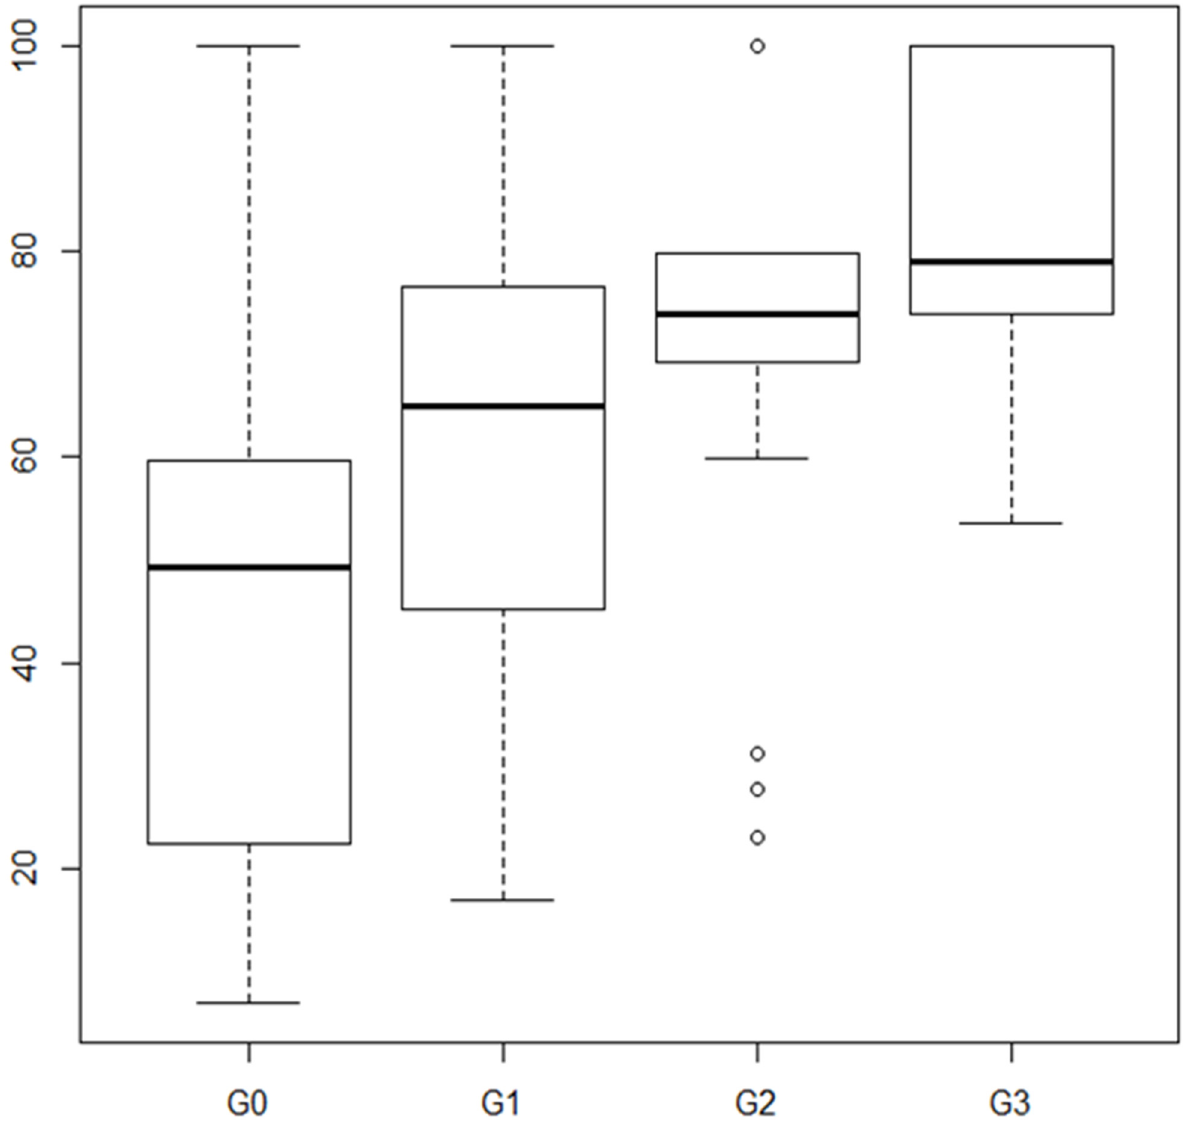
Figure 2. Relationship between quality of life (VAS) and the groups resulting from categorizing the score obtained by the estimated predictive model. Table 3. Relationship between VAS and the explanatory variables. In the dichotomous variables, 0 is NO and 1 is YES. The values 0, 1, 2, and 3 for age, menarche, menopause, and BMI correspond to the respective values for the first, second, third, and fourth quartiles. For the number of children, 0 corresponds to no children, 1 to one child, and 2 to two or more children. For the variables physical activity, sun exposure, and calcium intake, the scale from 0 to 4 corresponds to a Likert-type scale where 0 indicates absence and 4 indicates maximum adherence/exposure to the associated